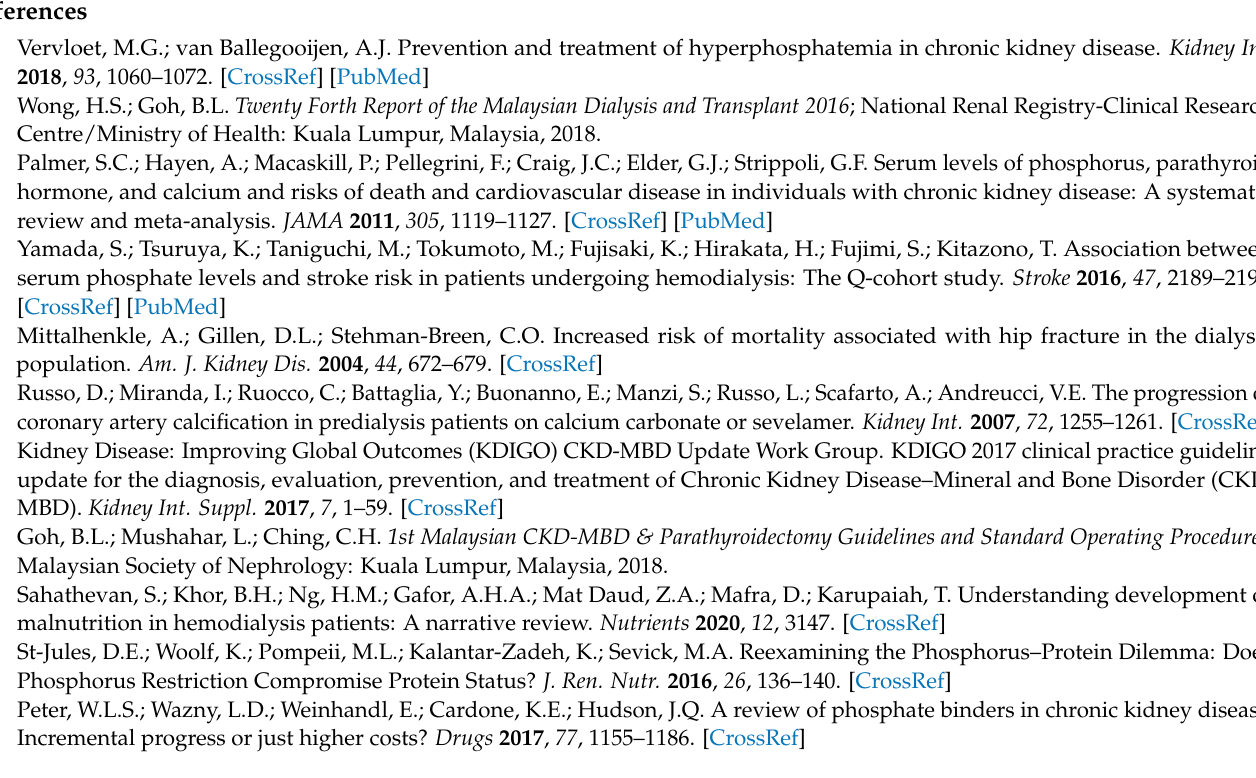
Table S3: Characteristics of Expert Reviewers; Table S4: Knowledge-based accuracy feedback from the expert panel; Table S5: Knowledge-based accuracy feedback from the expert